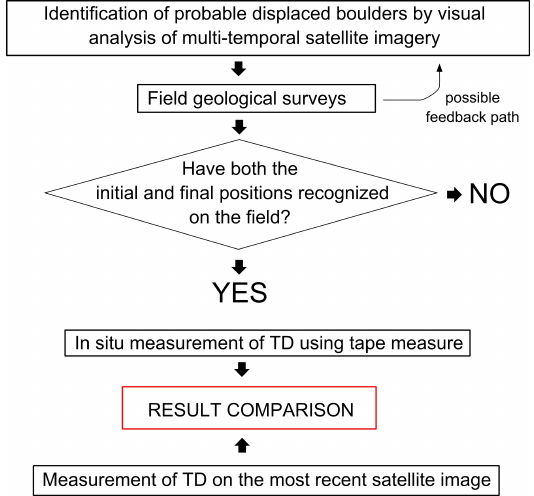
Figure 2. Flowchart explaining TD measuring and